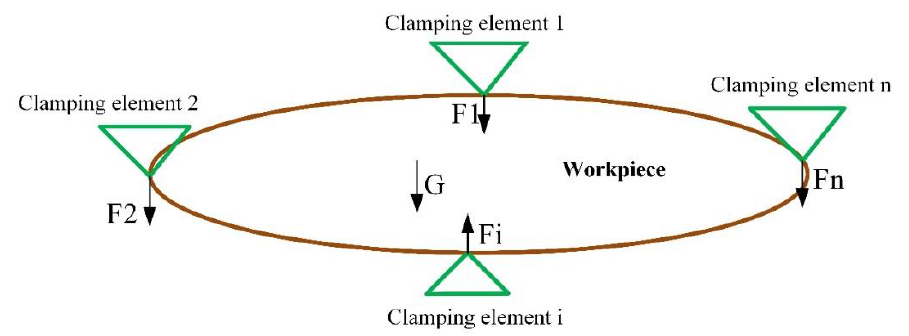
Figure 2. Workpiece clamping force model.